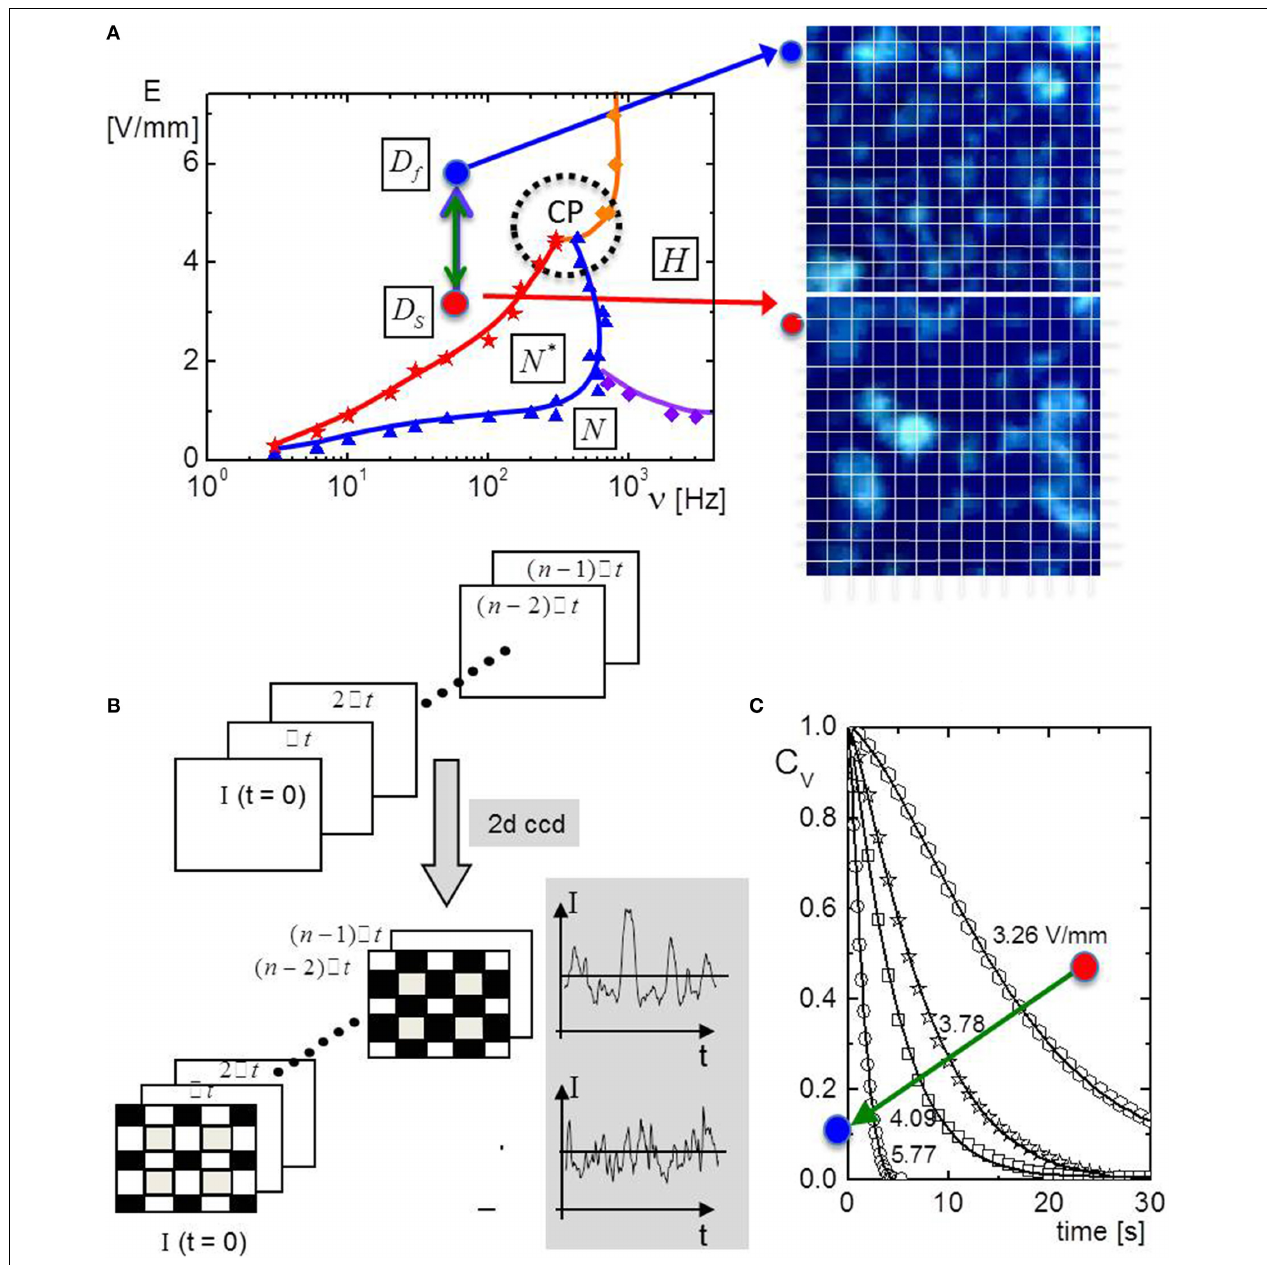
FIGURE 2 | (A) A simplified electric phase/state diagram, with two depolarized CCD-camera snap shots are shown, one in the slow dynamical state D S (red dot), and one in the fast dynamical state D f (blue dot). CP is the critical point that multi-transition lines meet. (B) The principle of image-time correlation spectroscopy. Time-resolved image are taken with a CCD camera. For each pixel a time trace is thus recorded (the plots show a typical time trace in the slow dynamical state, upper plot, and within the fast dynamical state, the lower plot). From these